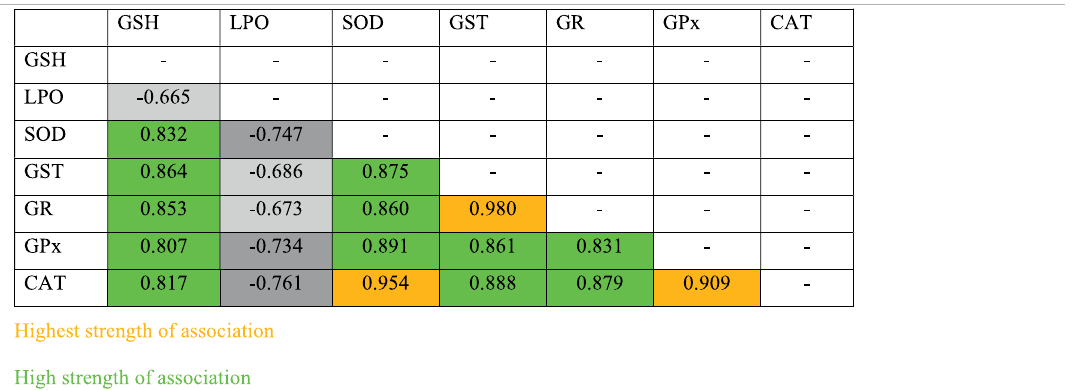
TABLE 1 | Strength of association between variables for individual antioxidant